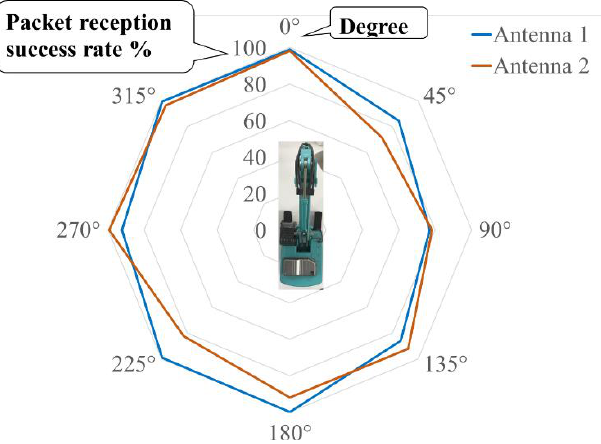
Figure 7. Average packet reception success rate in each direction: The blue line is the antenna 1’s results, and the orange line is the antenna 2’s results, respectively. The communication distance is 10 m.